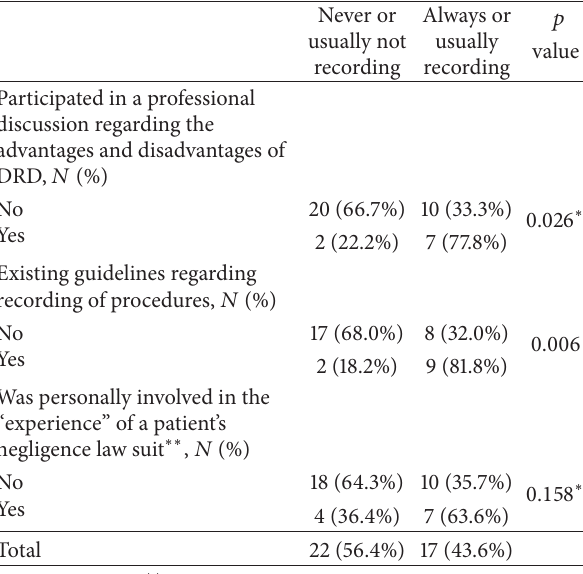
Table 3: Actual DRD rates amongst gastroenterologists.